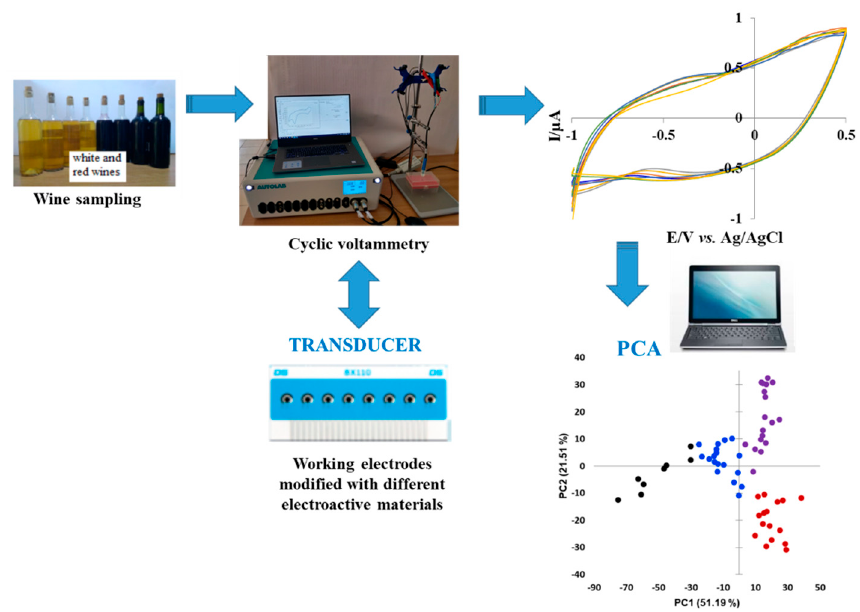
Figure 2. Schematic illustration of the methodology used for wine authentication in the case of ET based on screen-printed electrodes modified with electroactive materials.